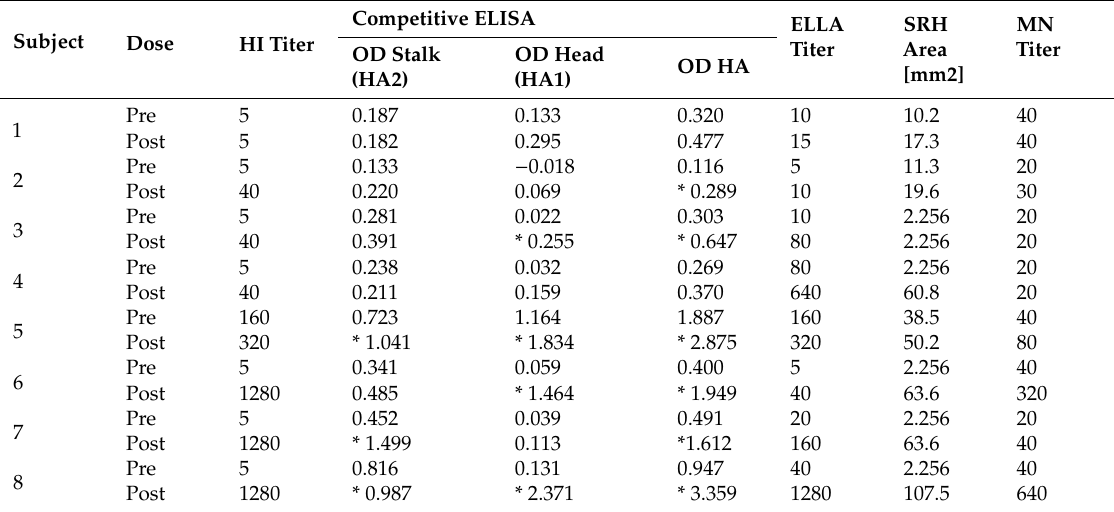
Table 1. Samples from adult subjects tested by the HI, ELISA, ELLA, SRH and MN